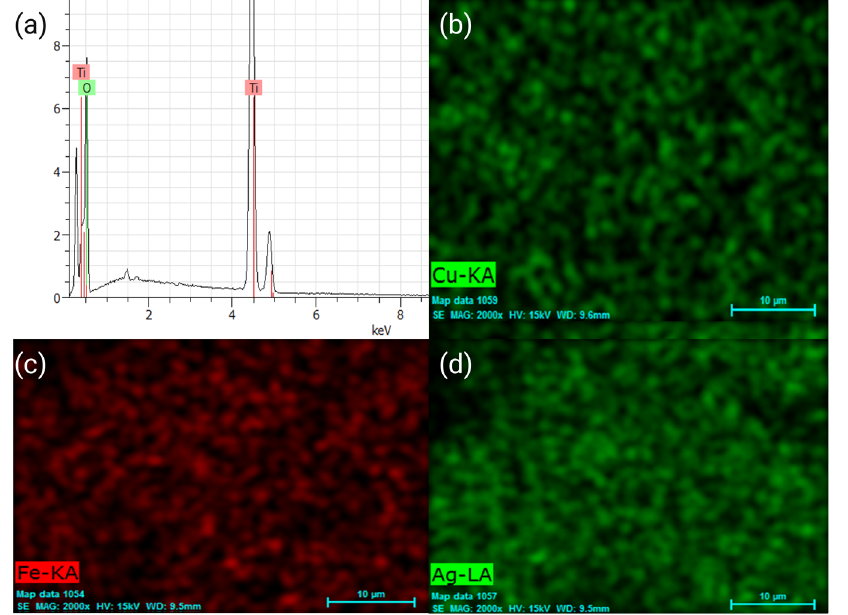
Figure 2. Elemental analysis of the ( a ) SG-TiO 2 and elemental mappings of ( b ) Cu, ( c ) Fe, and ( d ) Ag-doped TiO 2 .